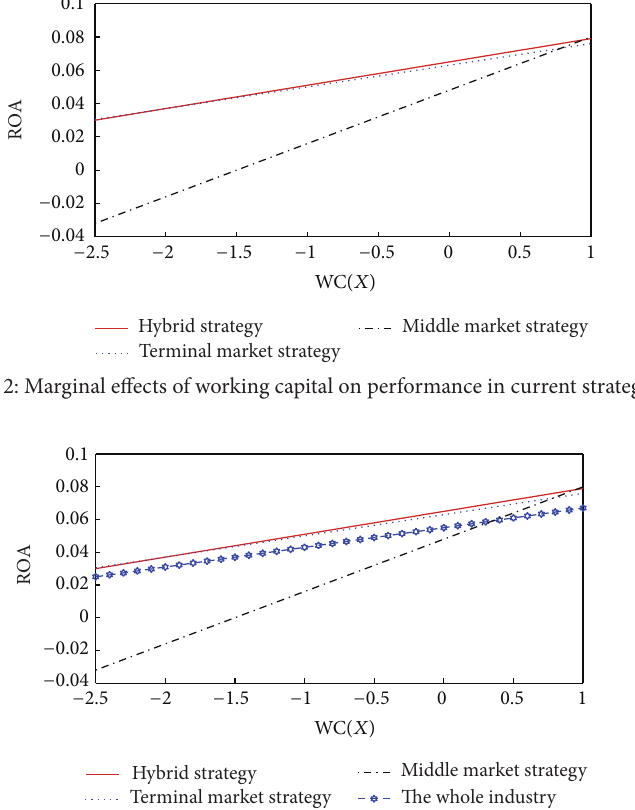
Figure 3: Margin effects of working capital on performance in current strategies and the whole